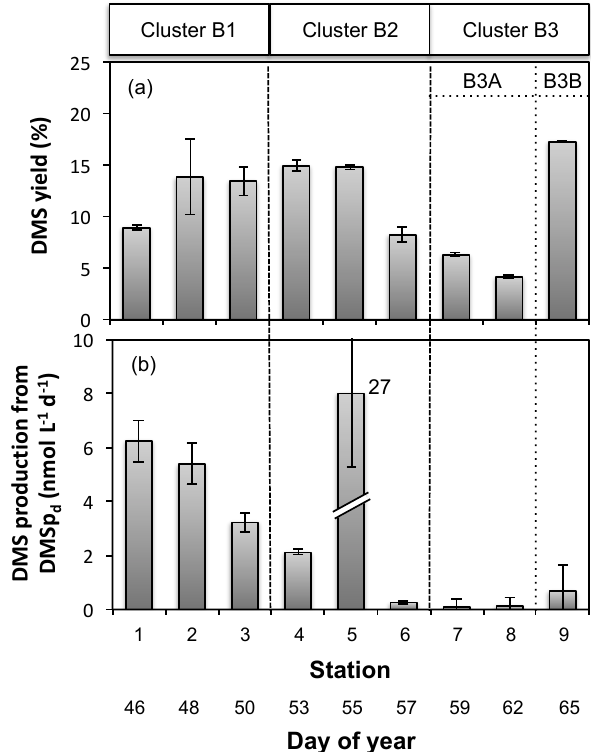
Figure 4. (a) Microbial DMS yields (%) and (b) gross DMS pro- duction from DMSP d (nmolL − 1 day − 1 ) at nine stations during the SOAP voyage in February and March 2012. The three distinct sam- pling clusters are noted as B1, B2, and B3. Stacks and error bars indicate mean and standard deviation of triplicate